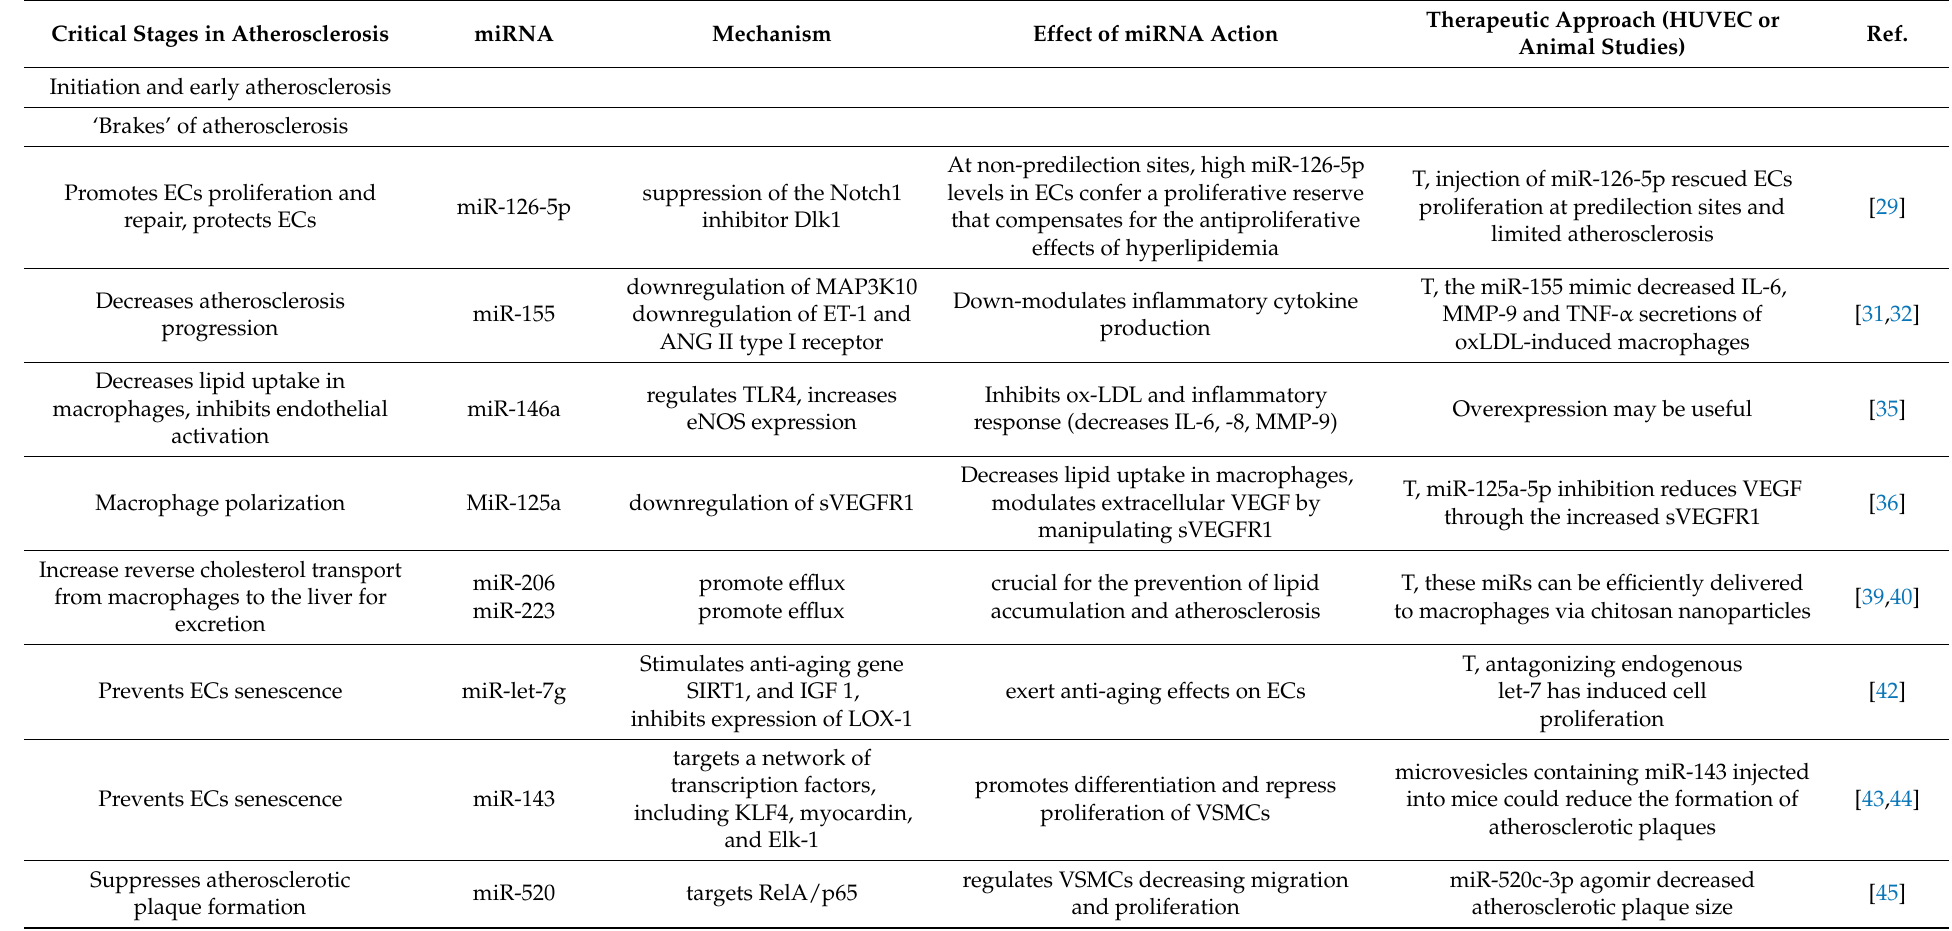
Table 1. Critical miRNAs participating in atherosclerotic carotid artery lesions development: from fatty streaks to mature plaque: a therapeutic